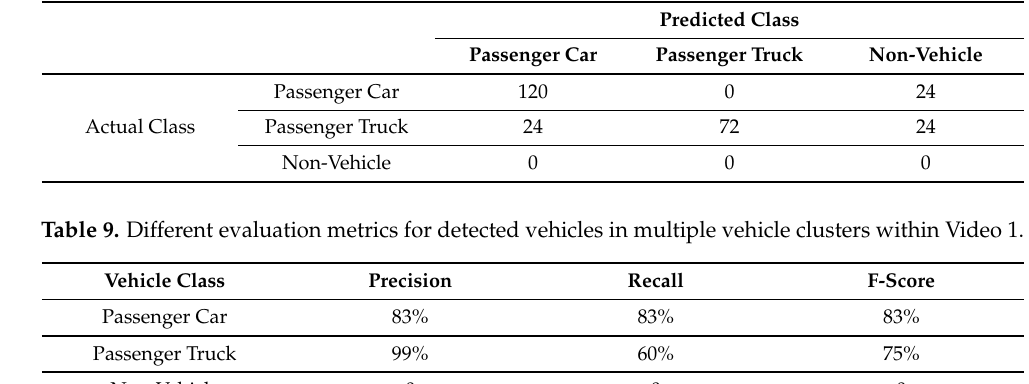
Figure 11. ROC curves for Video 1 classification. Table 8. Multiple vehicle cluster detections confusion matrix for Video 1.